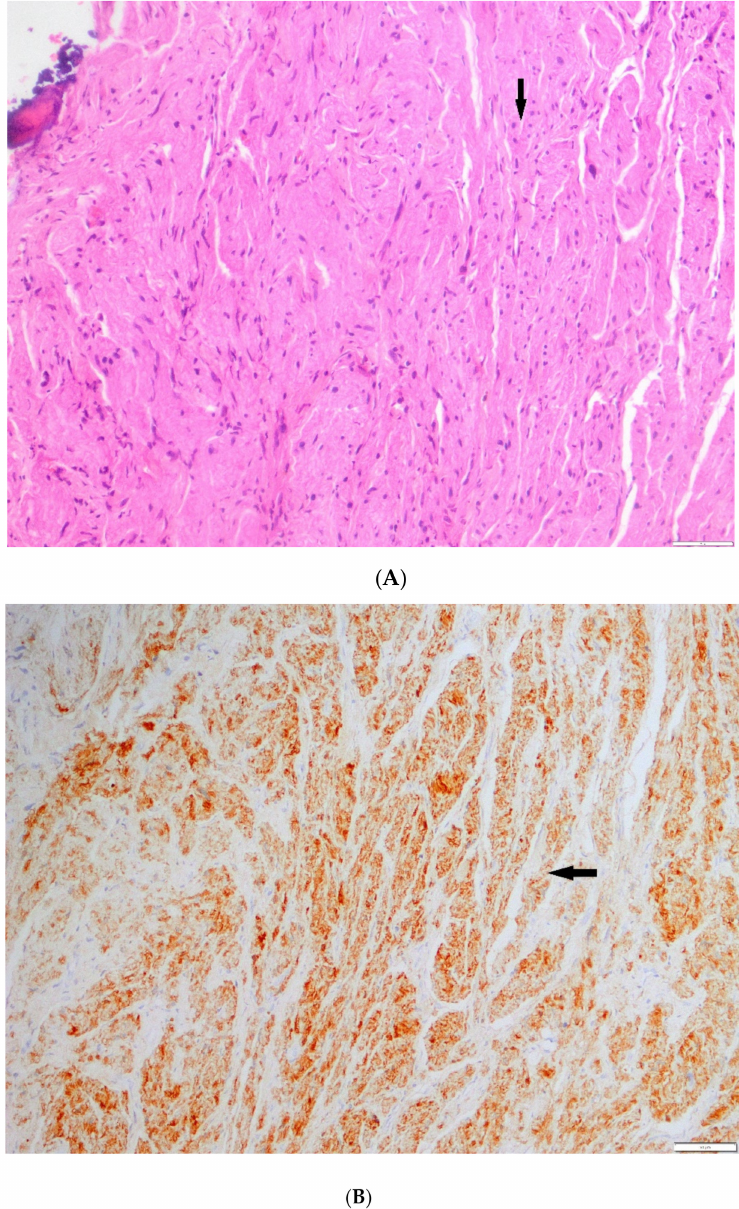
Figure 5. Describes case #4 (Tables 1 and 2), a patient managed initially with naxitamab and GM- CSF with no objective response (MIBG and PET-FDG diffusely positive in multiple bone lesions). Subsequently patient received HITS showing an objective response (lower Curie score) and PET-FDG turning negative. ( A ) Bone tissue diffusely infiltrated by tumor composed of Schwannian stroma (arrow), ( B ) S-100 immunostaining depicting massive Schwannian stroma (arrow). Figure 6 describes case #5 (Tables 1 and 2). Patient was diagnosed of stage 4 NB presenting with sudden onset of amaurosis due to a rapidly growing NB invading the sphe- noid. After 7 cycles of induction chemotherapy, 123I-MIBG SPECT scan persisted positive in the sphenoid and clivus (Curie score = 1). The patient then was enrolled in the 201 Ymabs Trial and after 4 cycles 123I-MIBG SPECT scan became negative. The patient received 4 more cycles of immunotherapy and after the 8th cycle, 123I-MIBG SPECT scan became positive again in the right side of the sphenoid. Because of this abnormal uptake in the 123 I- MIBG SPECT scan interpreted as NB recurrence, the patient was taken off trial and received 2 cycles of irinotecan and TMZ, and radiotherapy to the skull base. Post radiotherapy, 123I- MIBG SPECT scan persisted positive in the sphenoid area with no other sites of